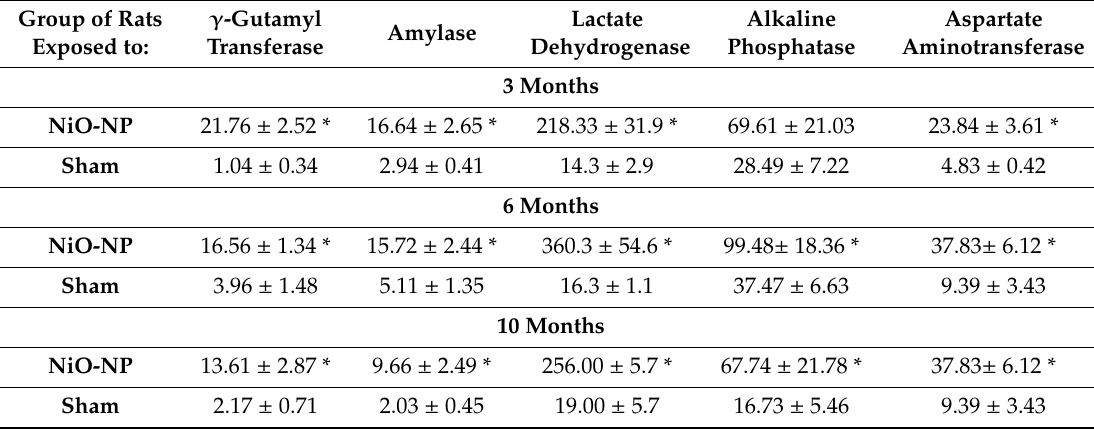
Table 5. Some enzymes in the BALF supernatant obtained 24 h after the last 4 h inhalation exposure to NiO-NPs at a 0.23 ± 0.01 mg / m 3 concentration repeated daily for 3, 6, or 10 months; mean results for at least 12 rats in exposed and sham-exposed groups of each term ( x ± s.e.